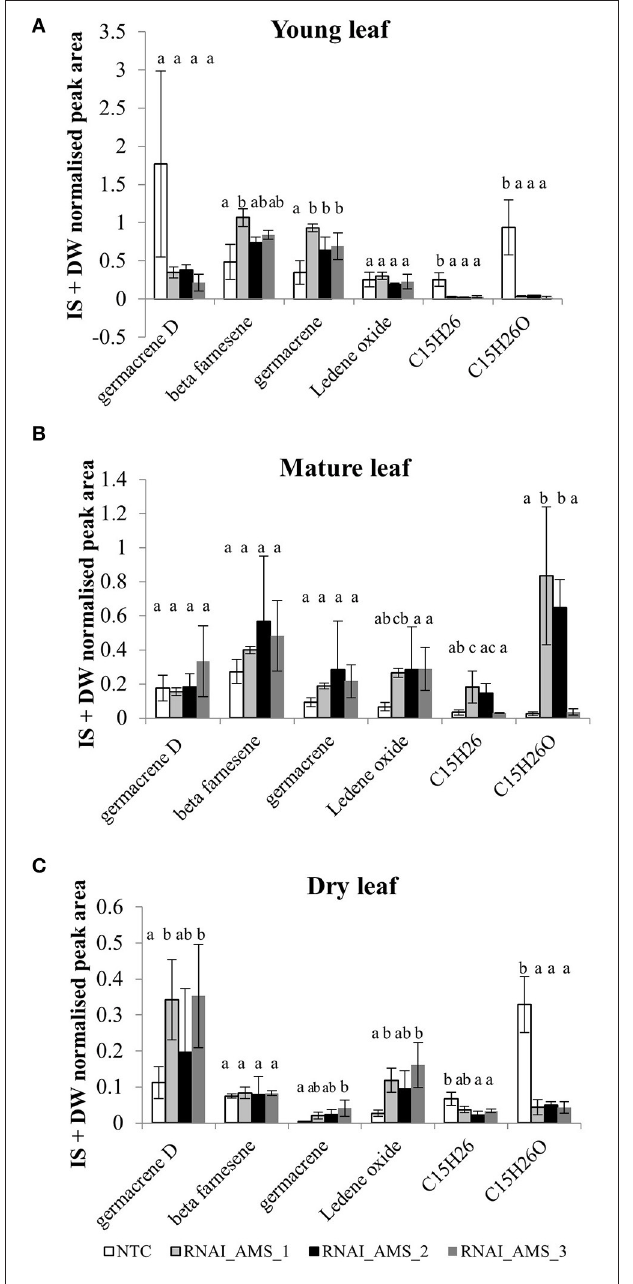
FIGURE 8 | Internal standard (IS) and dry weight normalized peak area averages for sesquiterpene levels in (A) young leaf, (B) mature leaf, and (C) -pooled dried leaf material in NTC and AMS silenced lines. Error bars ± SD (NTC— n = 6, AMS _RNAi— n = 3). Letters represent Bonferroni test results after ANOVA, groups not sharing letters indicate statistically significant differences ( p ≤ 0.05).